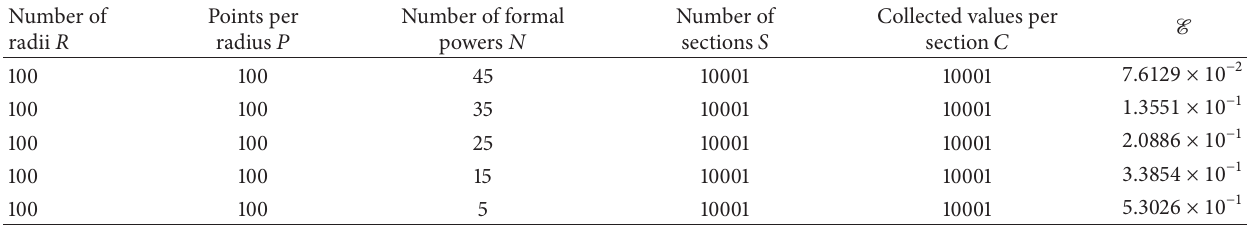
Table 14: Relation between the error E and the number of formal powers 𝑁 , when 𝜎 = 2 + sin (𝑥 + 𝑦) . Number of radii 𝑅